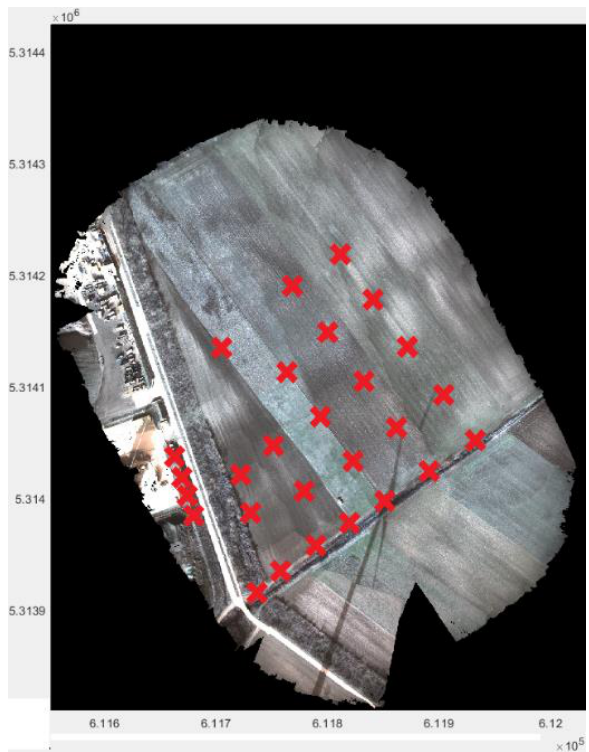
Figure 3 GCP locations in the acquisition area